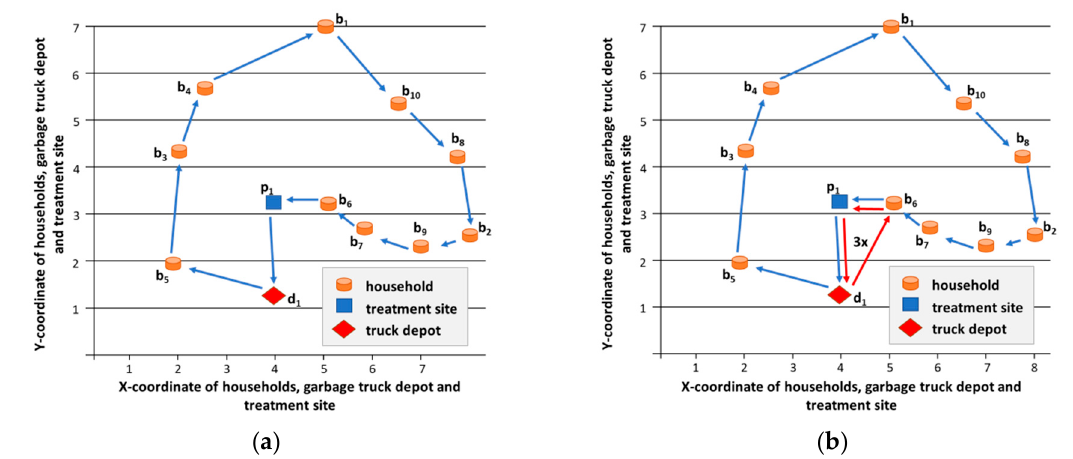
Figure 12. Collection routes: ( a ) Original route. ( b ) If overload of garbage truck is not allowed, then three additional collection routes must be inserted.